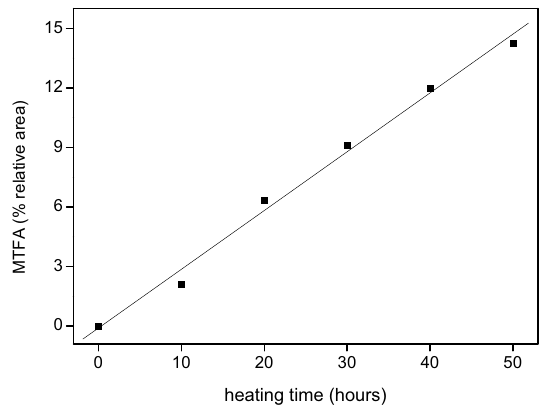
Fig. 2 – MTFA contents as a function of soy oil heating time (obtained from data determined by Sanibal and Mancini-Filho (2004); r = 0.996; p < 0.0001; y= –0.110 +